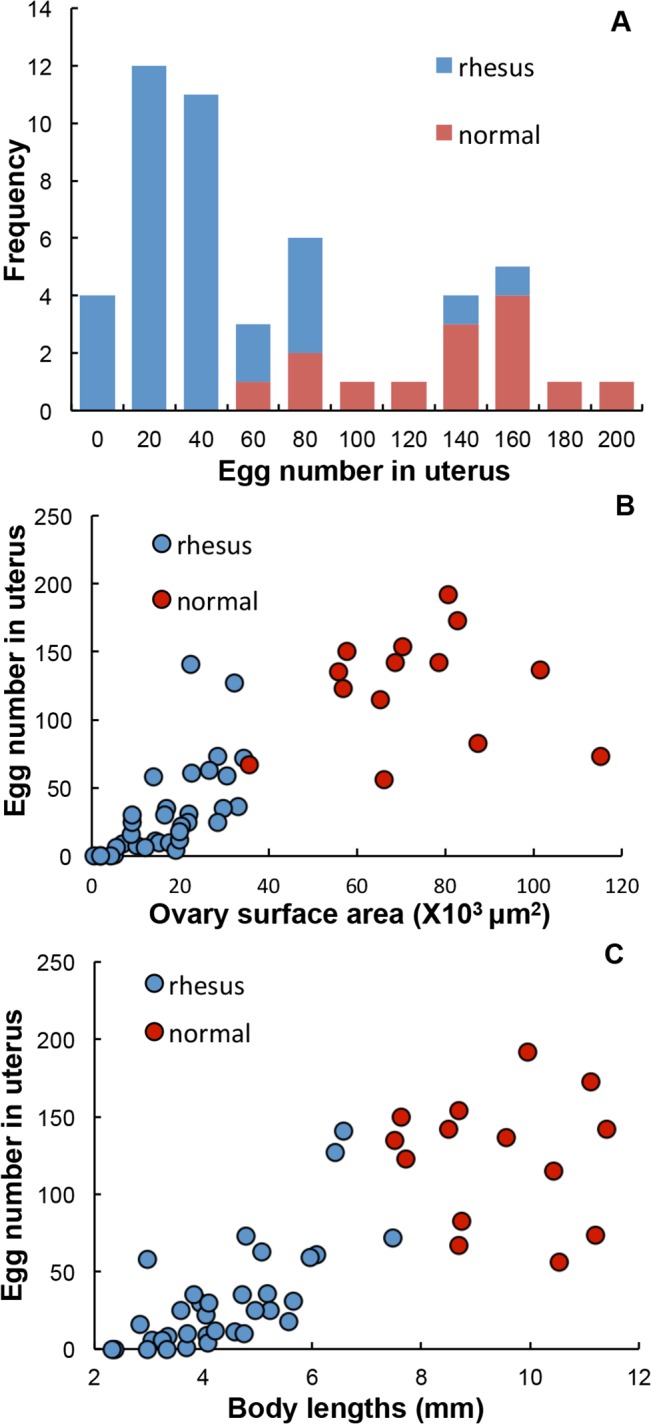
Reproductive capacities of female worms from rhesus macaques were diminished.(A) Egg number in the uterus of females from two populations. Those from rhesus macaques (blue) had a wide range from zero to 141, the majority having from 20 to 40 eggs. Those from permissive rabbit and mouse hosts also had a wide range of egg numbers, but with the majority between 140 and 160. (B) and (C) illustrate that ovary size and body length correlate positively with egg number in the uterus, with almost no overlap. Females from rhesus macaques (blue), had smaller ovaries (B), shorter bodies (C) and fewer eggs, compared to control females (red).